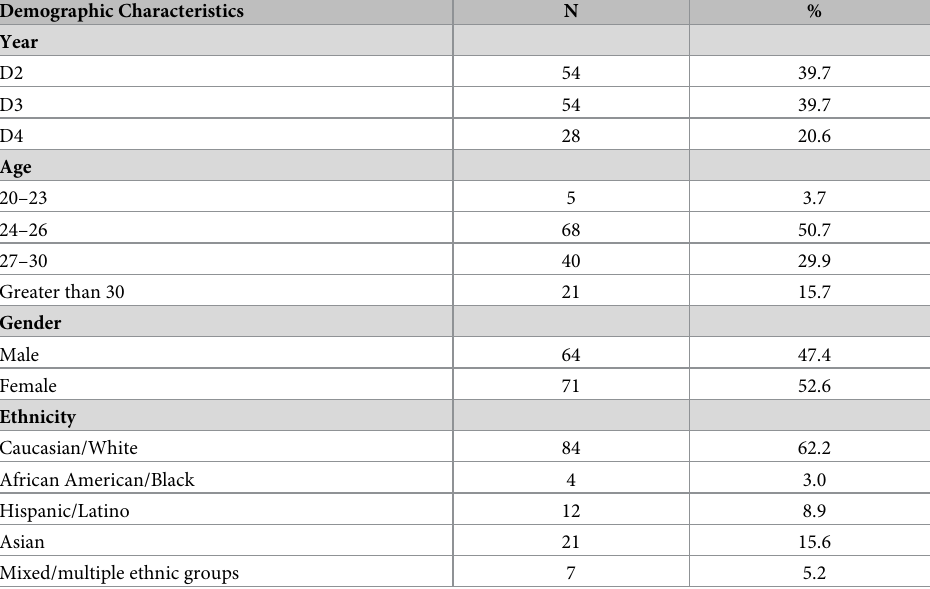
Table 1. Participants’